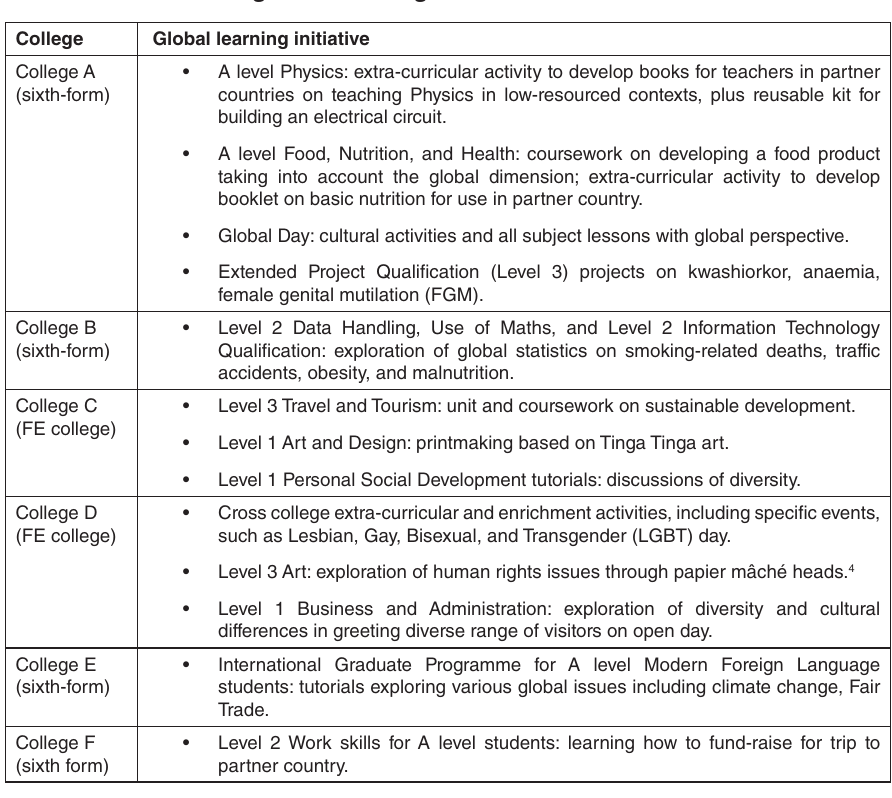
Table 1 offers an overview of the global learning initiatives chosen by colleges. They were often already involved in other global learning activities, but this article draws only on data from project activities. Table 1: Overview of global learning